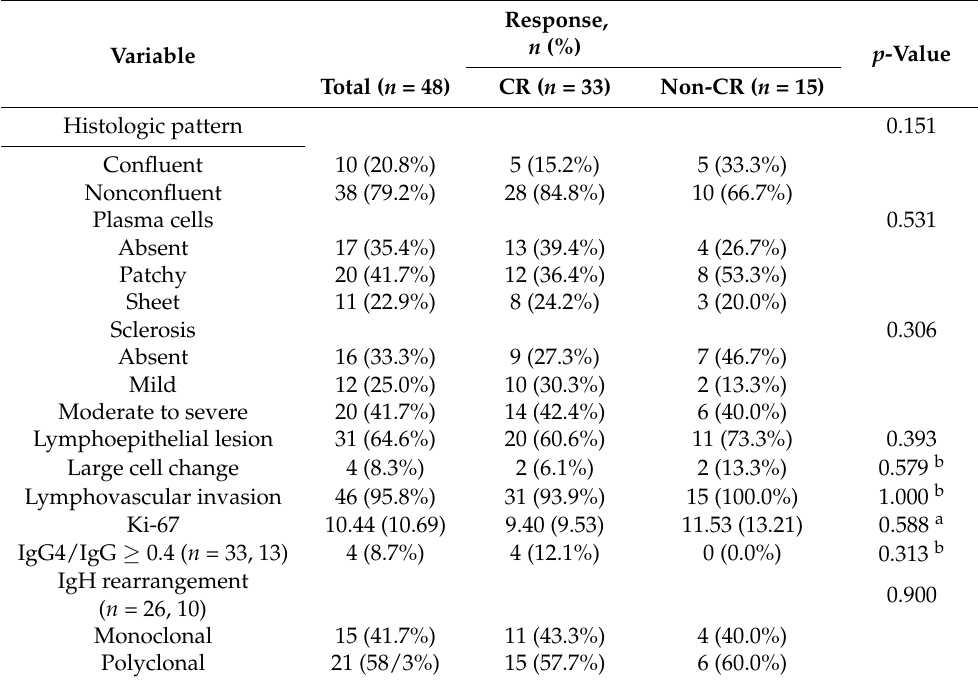
Table 2. Comparison of pathologic characteristics in complete remission group versus non-complete remission group in ocular adnexal MALT lymphoma.